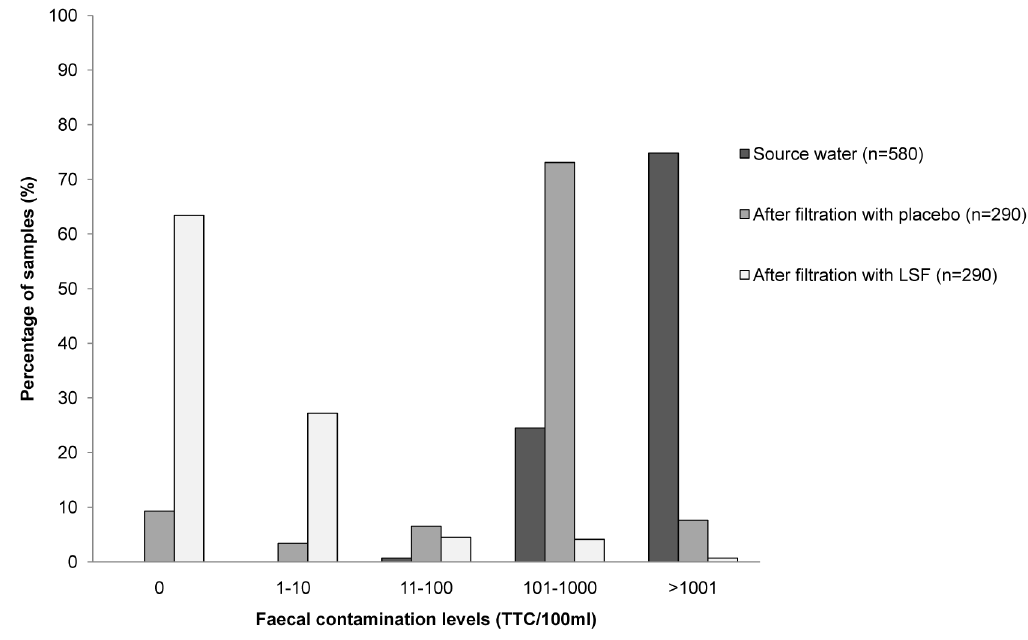
Figure 3. Percentage of water samples by level of contamination (TTC/100 ml).